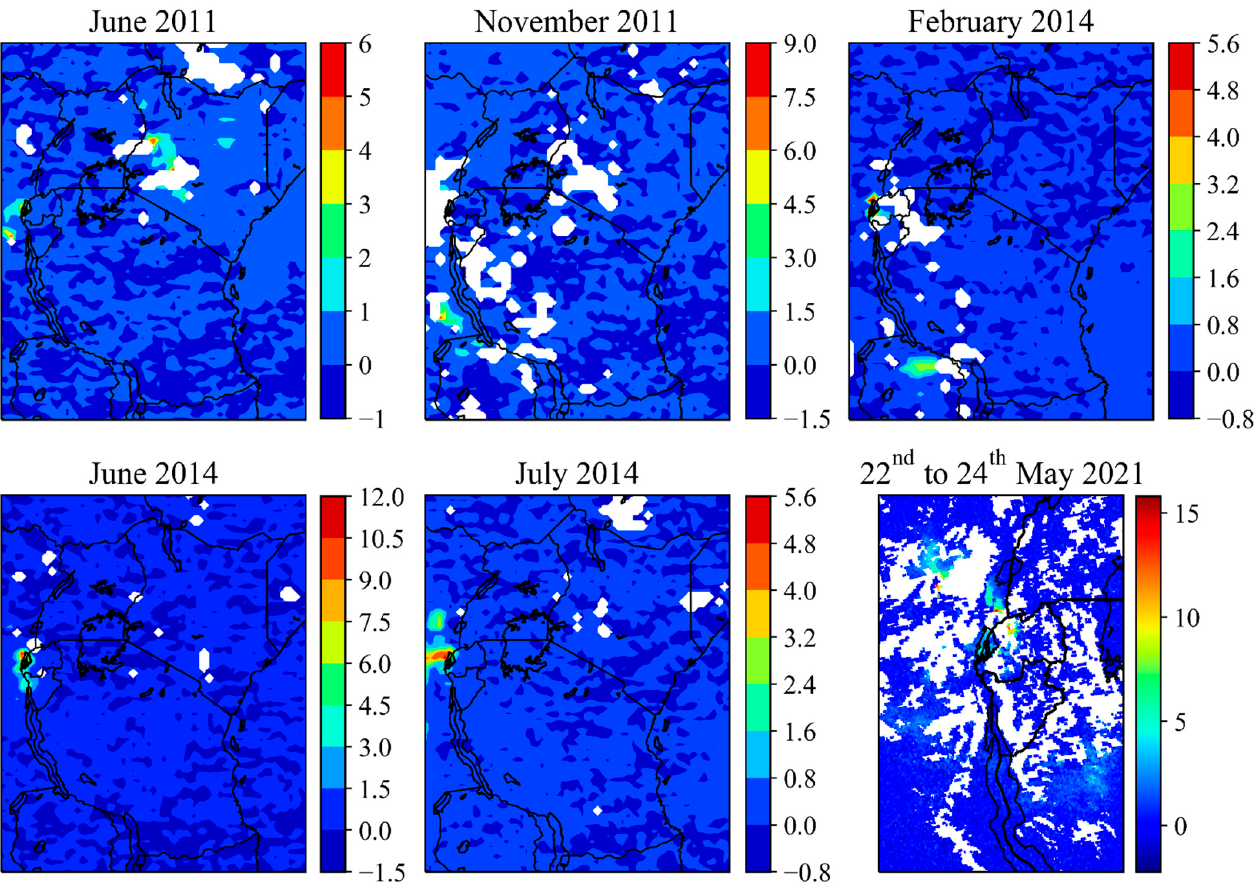
Figure 8. Spatial distribution of boundary layer SO 2 (in Dobson Units; DU) for the months with the highest monthly average